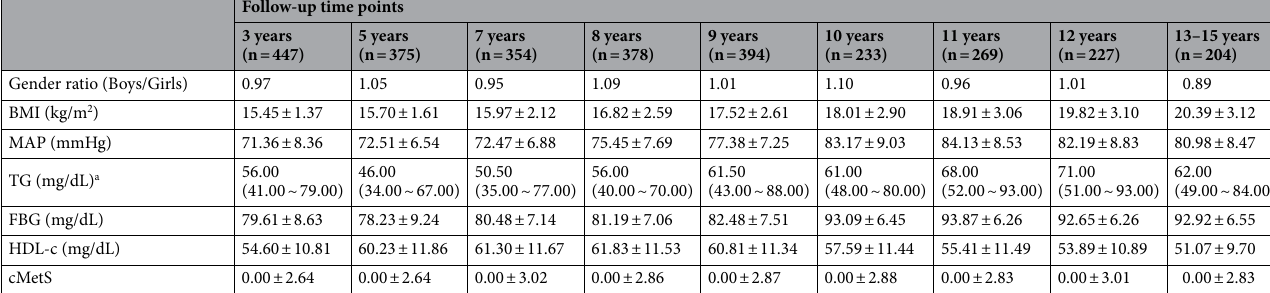
Table 1. Descriptive summary of metabolic syndrome components and cMetS by follow-up time points. SD, standard deviation; BMI, body mass index; MAP, mean arterial pressure; TG, triglyceride; FBG, fasting blood glucose; HDL-c, high-density lipoprotein-cholesterol; cMetS, continuous metabolic syndrome score. Mets components are presented as means and standard deviations. a TG is not distributed normally are presented as medians with interquartile ranges.